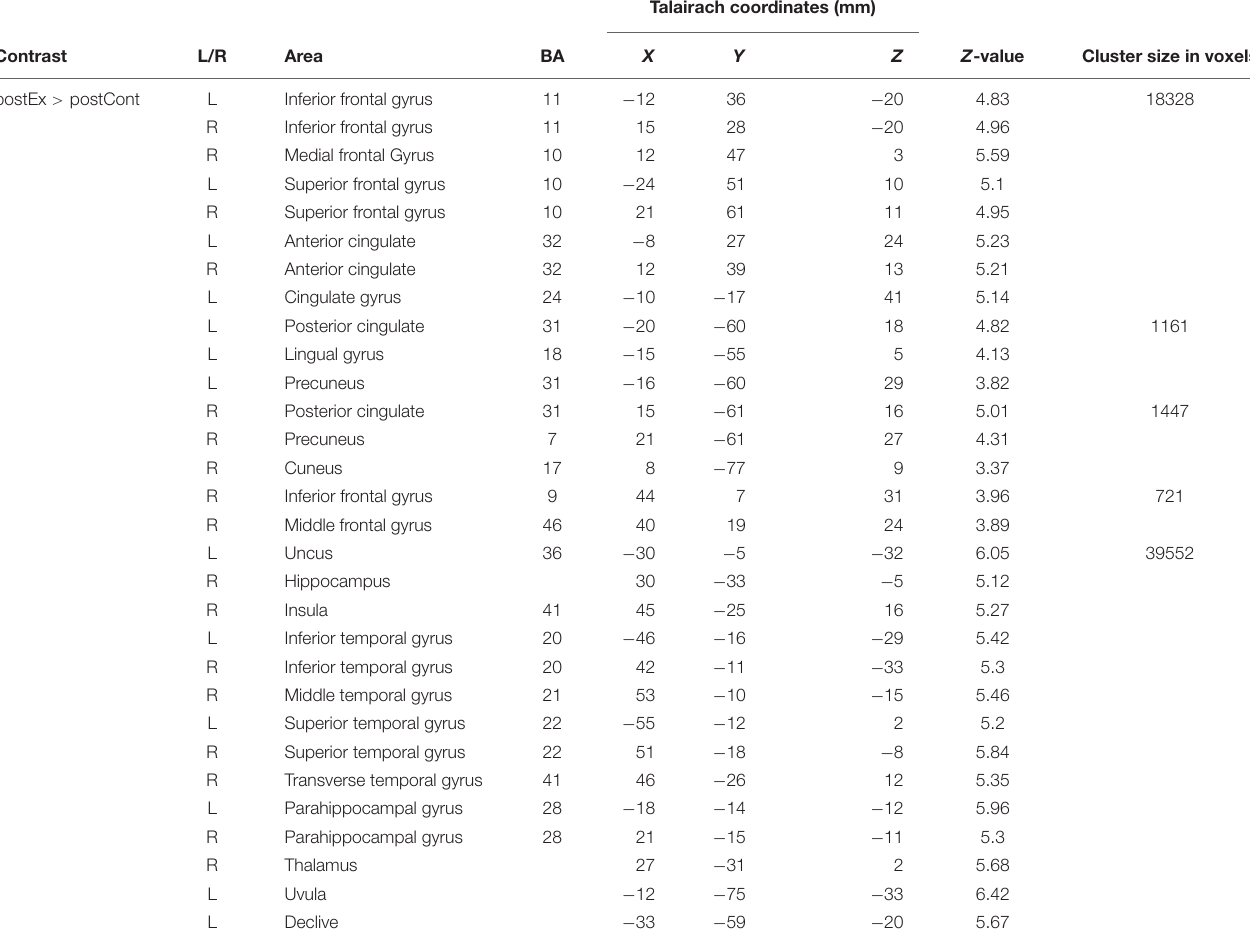
TABLE 3B | Cluster sizes, peak locations, and statistical values for regions showing significant post-intervention large in the Ex group compared to the Cont group.